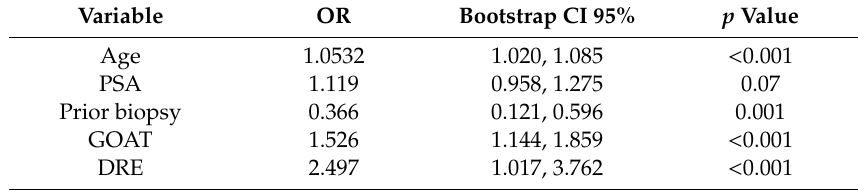
Table 5. Multivariate analysis of the association of plasma GOAT levels with the diagnosis of Significant PCa (SigPCa) in the patients with PSA a range of 3–10 ng / mL, adjusting with common clinical variables. Variable OR Bootstrap CI 95% p Value Age